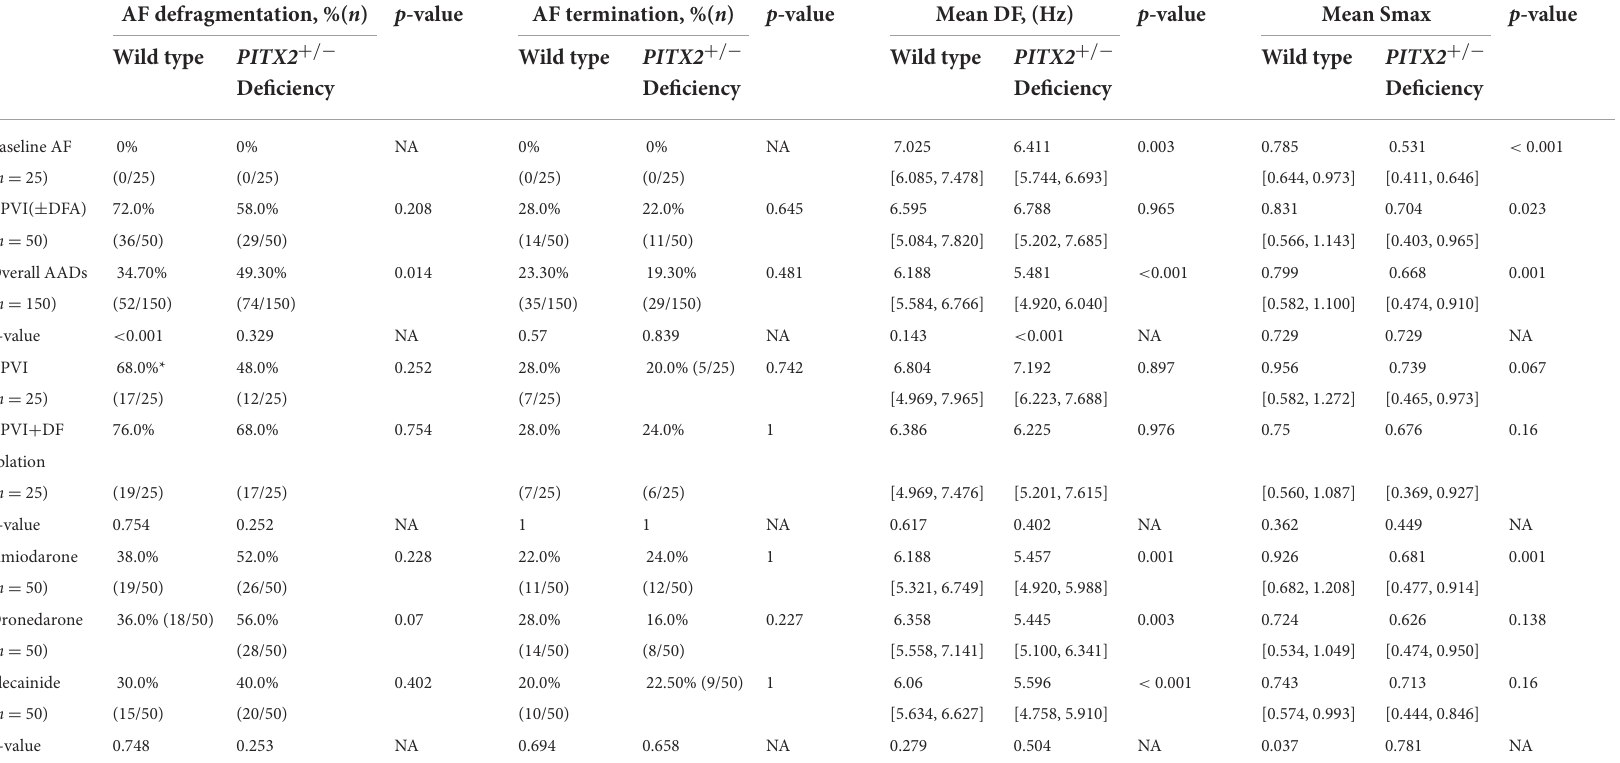
TABLE 2 Defragmentation rate and wave-dynamic changes after virtual interventions according to the